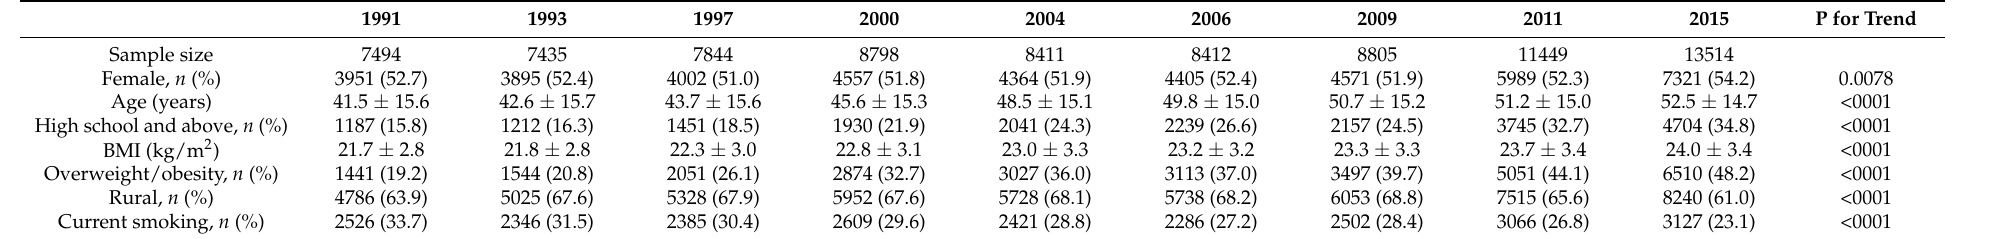
Table 1. Characteristics of the participants of the CHNS from 1991 to 2015.